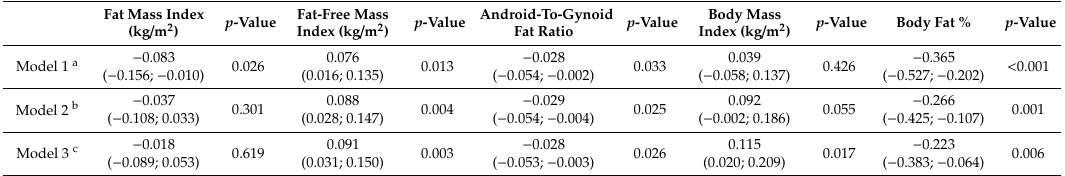
FatMassIndex (kg / m 2 ) p -Value